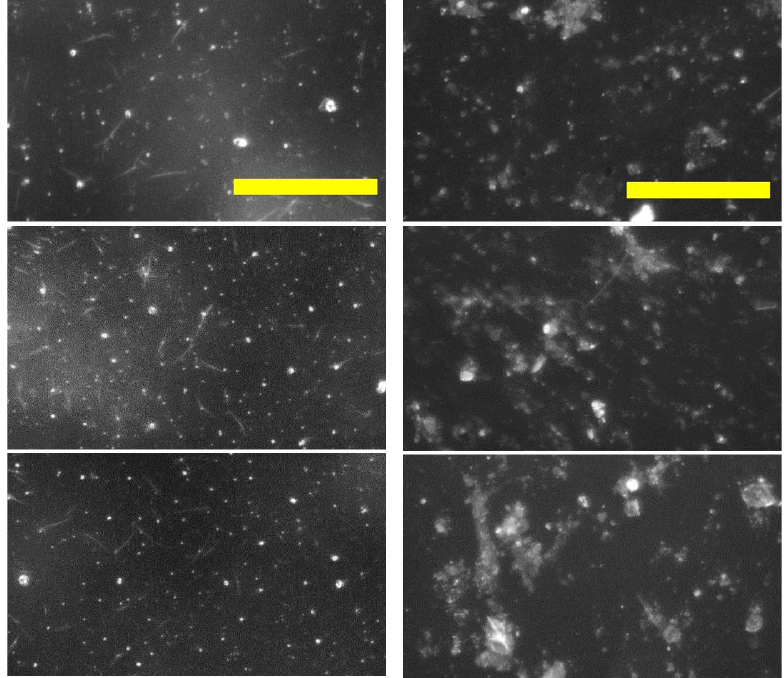
Figure 5. Raw images of asbestos samples obtained by HTM. Left column: PAT standard samples, Right column: on-site airborne samples (scale bar = 100